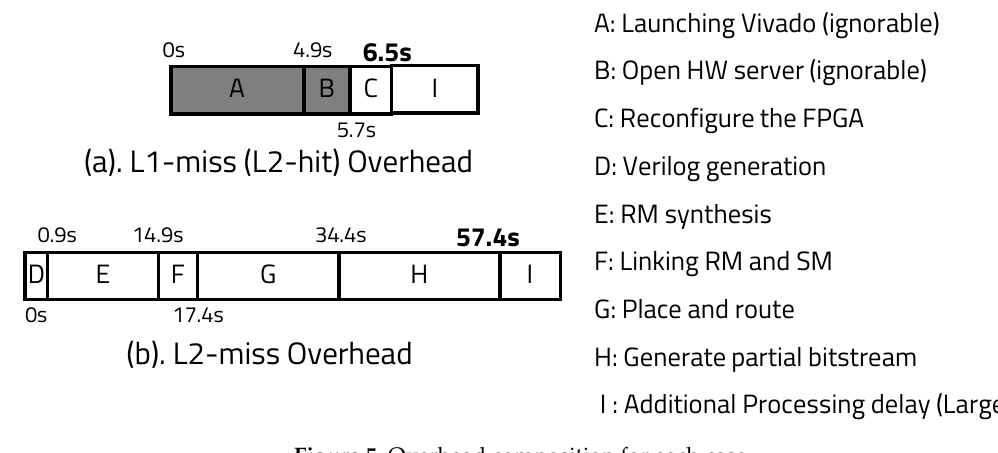
Figure 5. Overhead composition for each